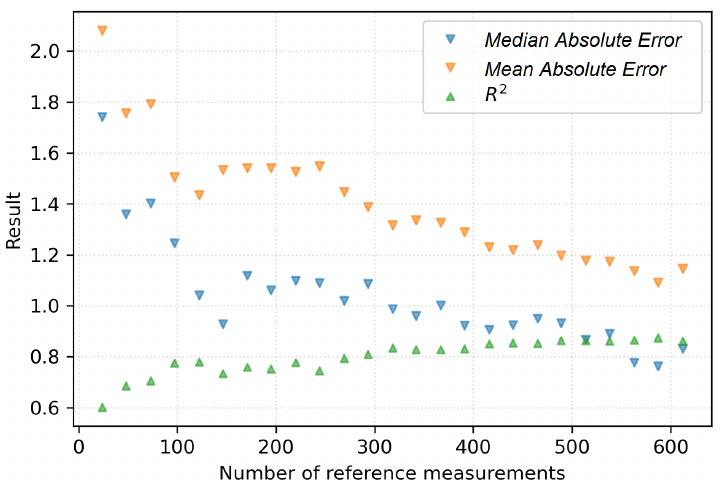
Figure 5. Model performance results for models trained on a narrowed reference measurements